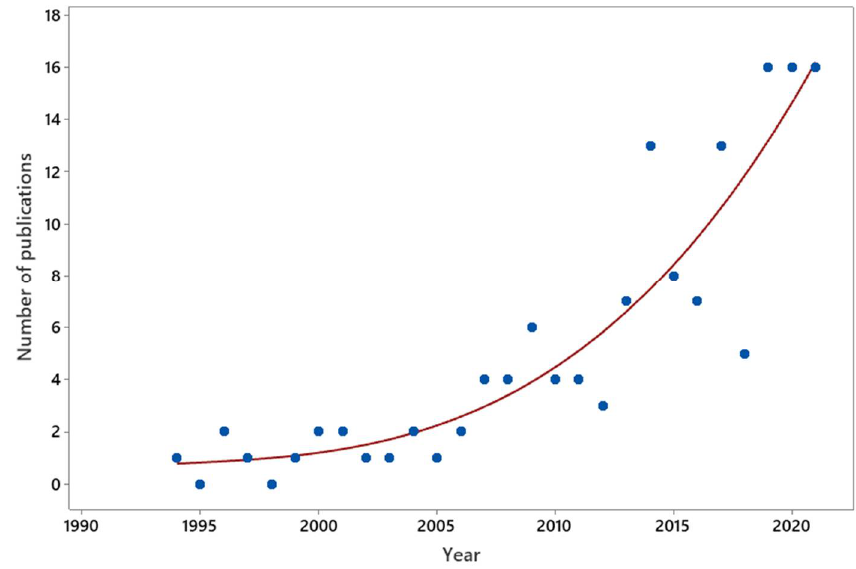
Figure 1. Number of publications using the terms ‘reptile enrichment’ from Web of Science over the past 30 years, as of October 2021.